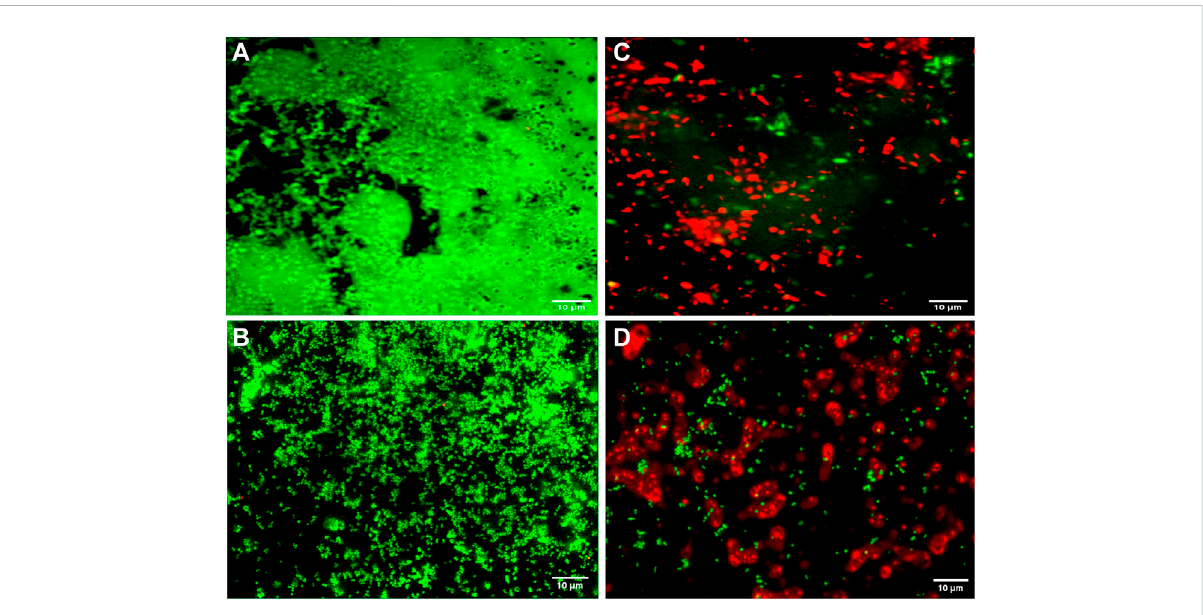
FIGURE 6 Fluorescence microscopic analysis of 24 h pre-formed bio fi lms under 100 × objective. Untreated pre-formed bio fi lms of (A) P. aeruginosa PAW1 and (B) S.aureus S8 with greater number ofviable cells (green)obtained at528 nmfor SYTO9 signal. CAAgNPs treated pre-formed bio fi lmsof (C) P. aeruginosa PAW1 and (D) S. aureus S8 with greater number of dead cells (red) obtained at 645 nm for PI signal. Few cells indicated by yellow- orange color were about to die.